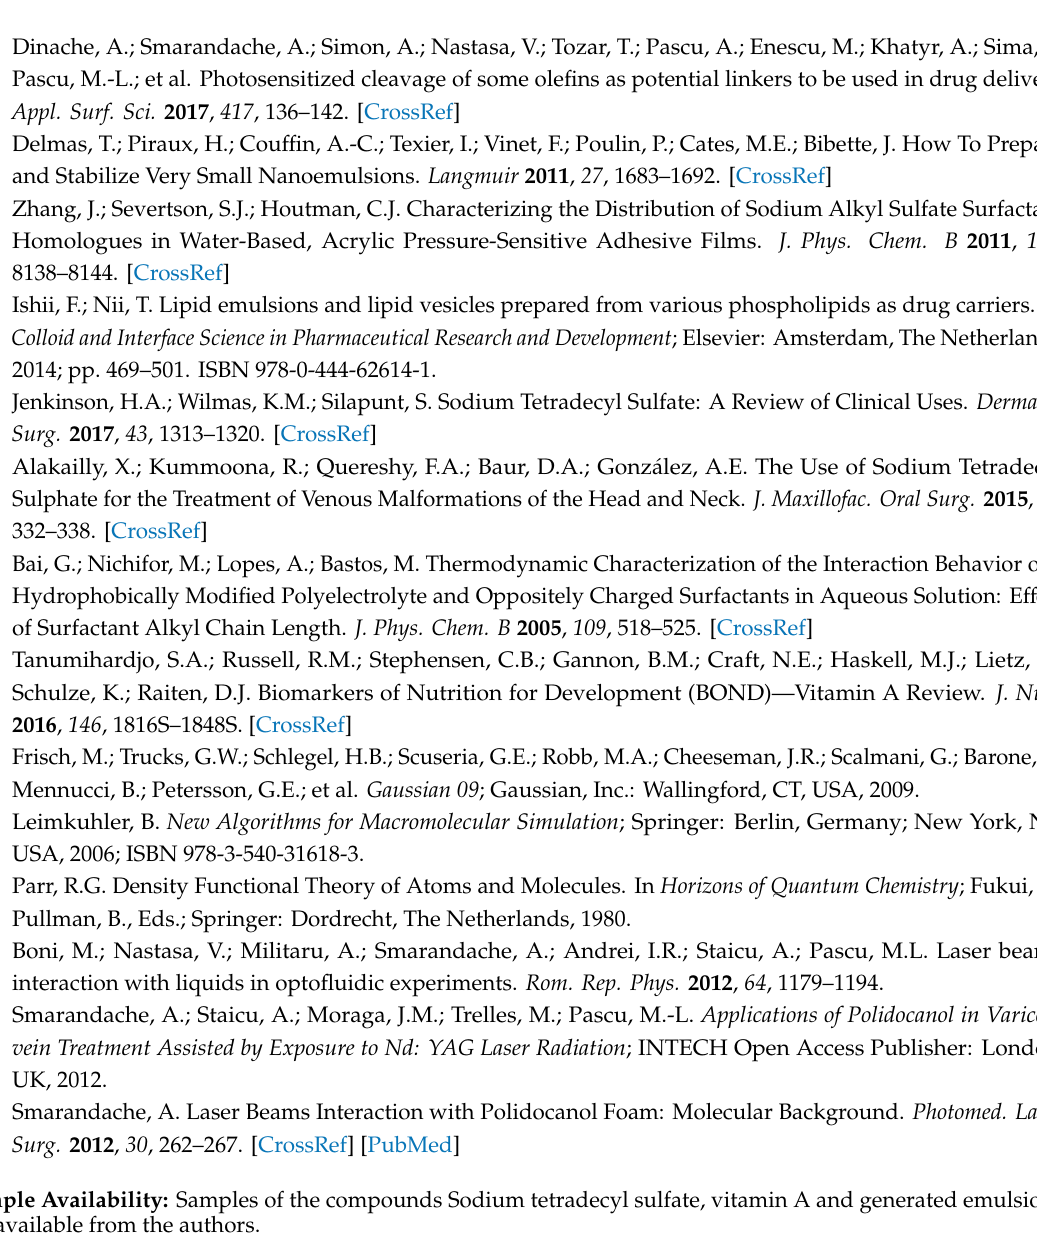
Sample Availability: Samples of the compounds Sodium tetradecyl sulfate, vitamin A and generated emulsions are available from the